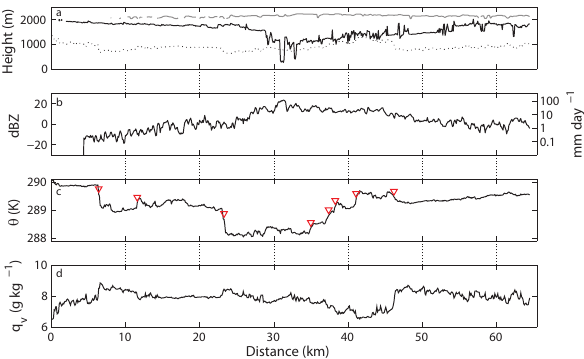
Fig. 1. Time series of aircraft data from a subcloud flight leg ( ∼ 150m) flown during RF04 (23 October 2008 ∼ 10:00UTC 20 ◦ S 83 ◦ W): (a) cloud top height (gray), cloud base height (solid black), and lifting condensation level at aircraft height (Bolton, 1980, dot- ted); (b) cloud base radar reflectivity, as measured by the WCR, and corresponding precipitation rate using a Z – R relationship from Comstock et al. (2004); (c) in situ potential temperature ( θ ), where the red triangles indicate the location of cold-pool edges, as iden- tified by the criteria described in the text; (d) in situ water vapor mixing ratio ( q v ). The distance along the x axis is approximated from the time series assuming the aircraft flies at a mean ground speed of 100ms − 1 .